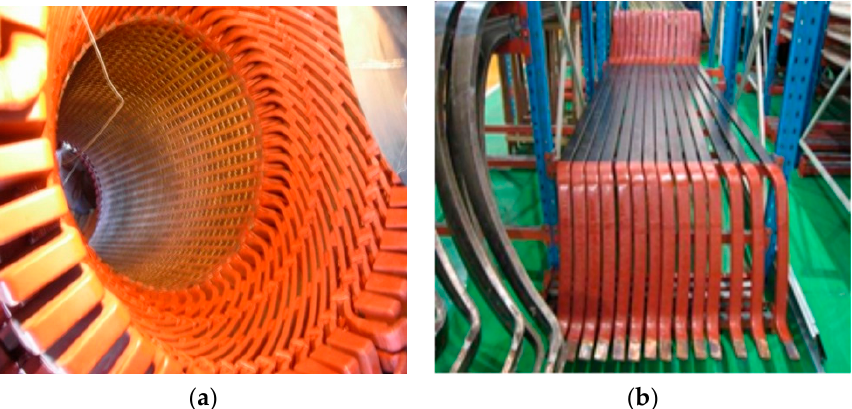
Figure 1. Photograph of a stator bar end: ( a ) Stator bar end structure of a large hydro generator; ( b ) Stator bar.